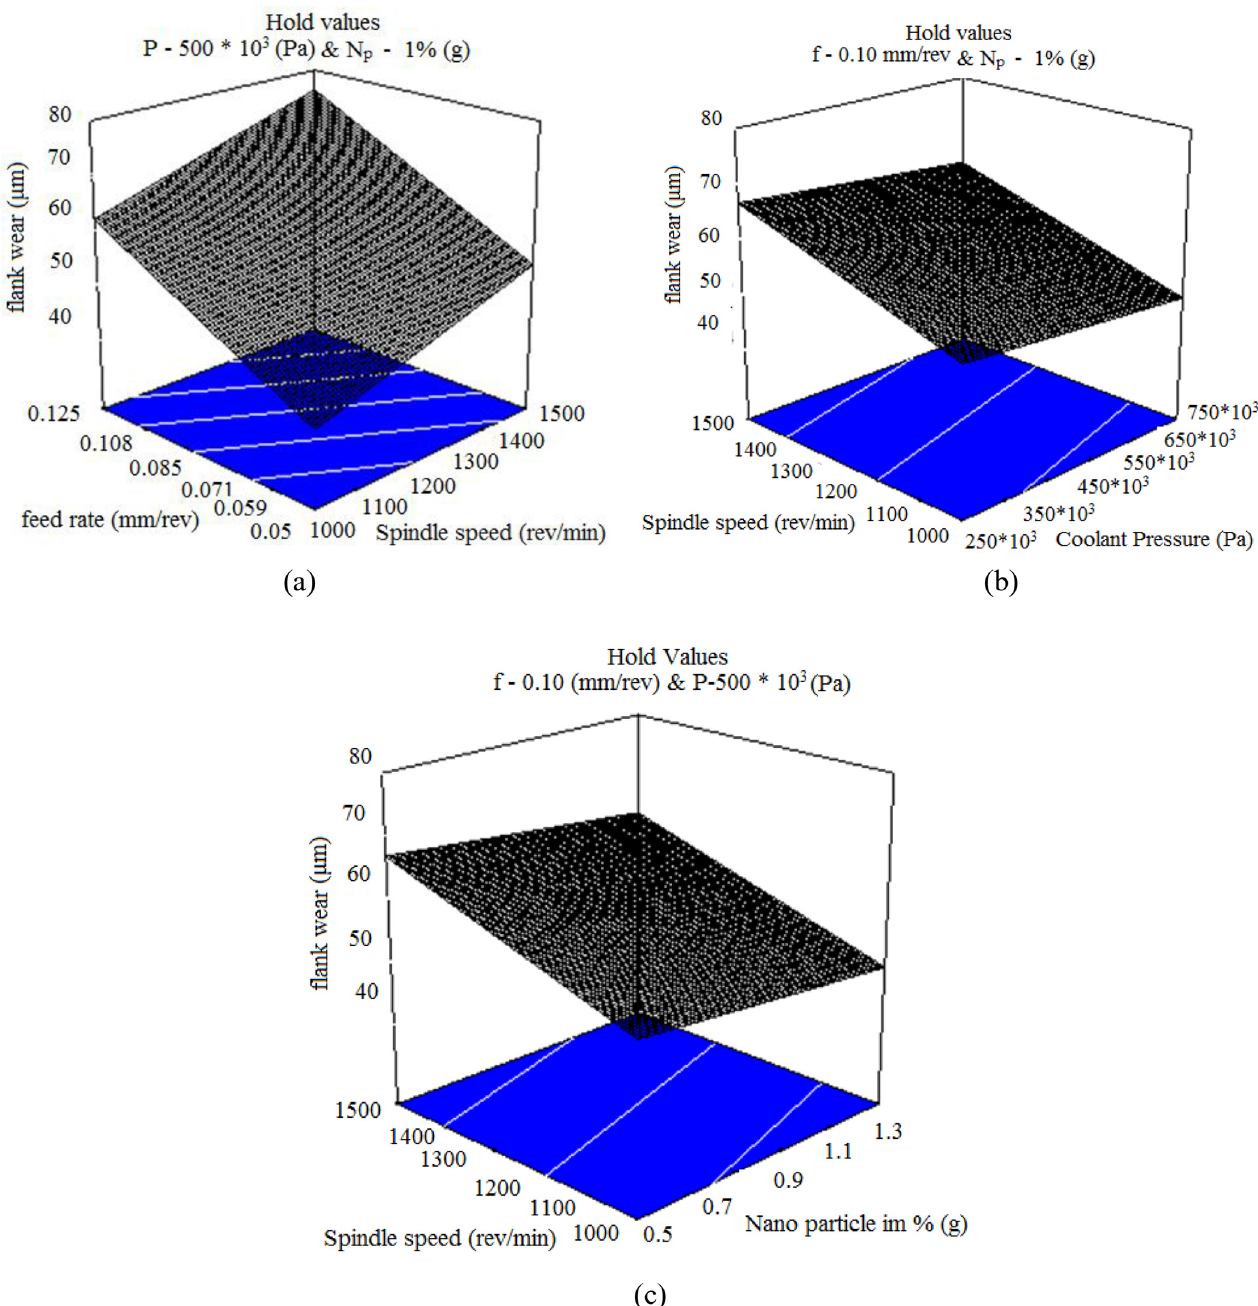
Fig. 11. (a-c) 3D plots for VB (a) 3D plots for VB at P (cid:1) 500* 10 3 and Np-1% (g), (b) 3D plots for VB at P (cid:1) 500* 10 3 and Np (cid:1) 1% (g), (c) 3D plots for VB at N-1250 rev/min and Np (cid:1) 1%